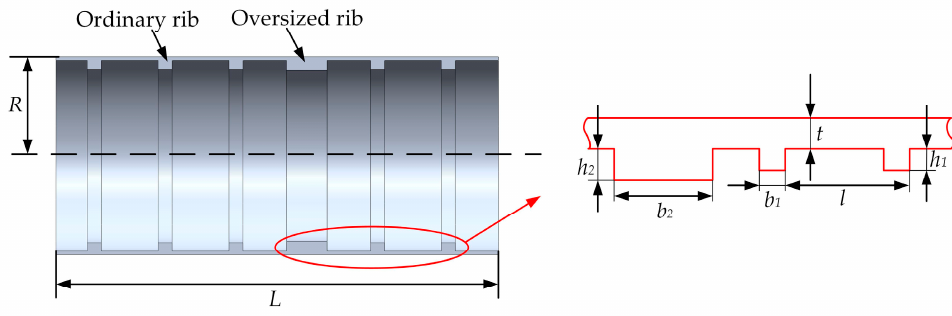
Figure 3. Structural parameters definition of ring rib cylindrical shell.